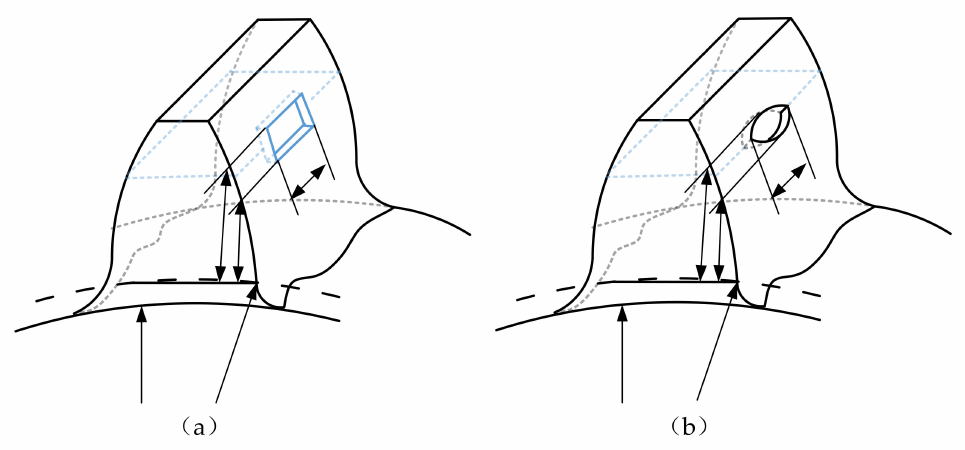
Figure 3. The model of tooth spalling: ( a ) Rectangular spalling, ( b ) Elliptic